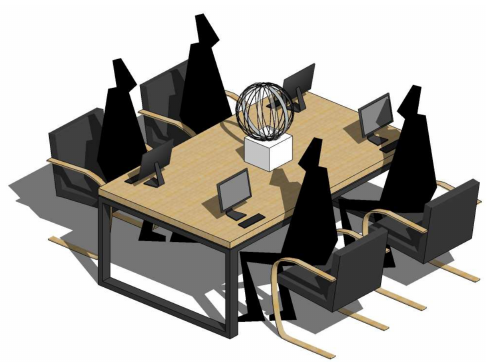
Figure 6. A working sketch of the omnidirectional WPT system based on rotary transmitting coil for household appliances. (Four computers are being charged wirelessly and simultaneously by the rotating